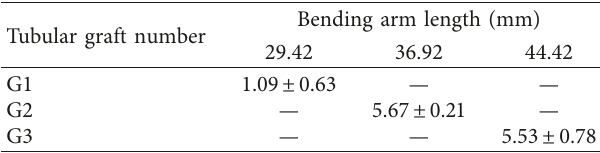
Figure 5: (a) Bending force curve and (b) curving angle when bending force reached the maximum. Bending arm lengths of tubular grafts and corresponding stent grafts: tubular graft G1 corresponds to A11 (29.42 mm), tubular graft G2 corresponds to A22 (36.92mm), and tubular graft G3 corresponds to A33 (44.42 mm). Table 4: Spring-back force of three tubular grafts at the curving angle of 5 ° with three bending arm lengths